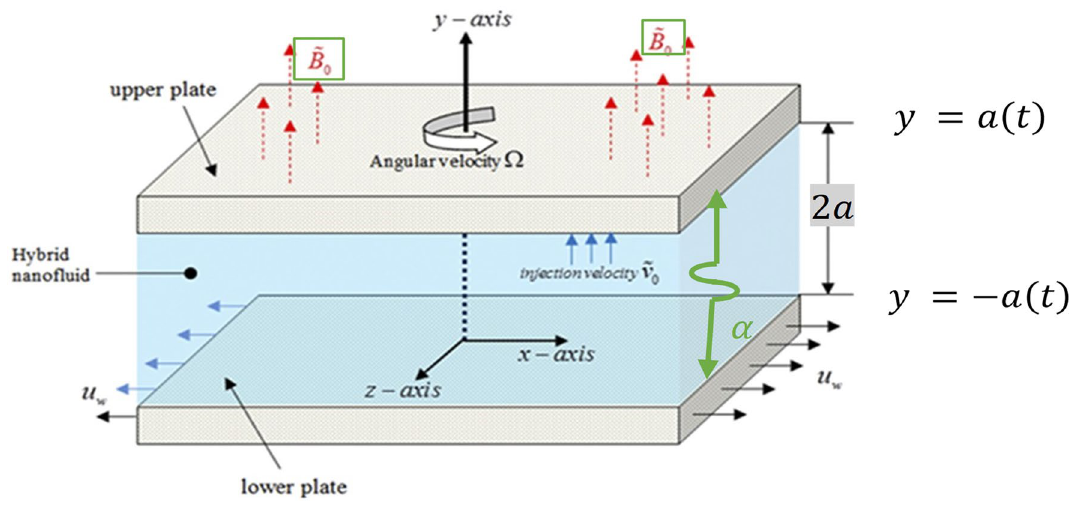
Figure 1. The geometry of the